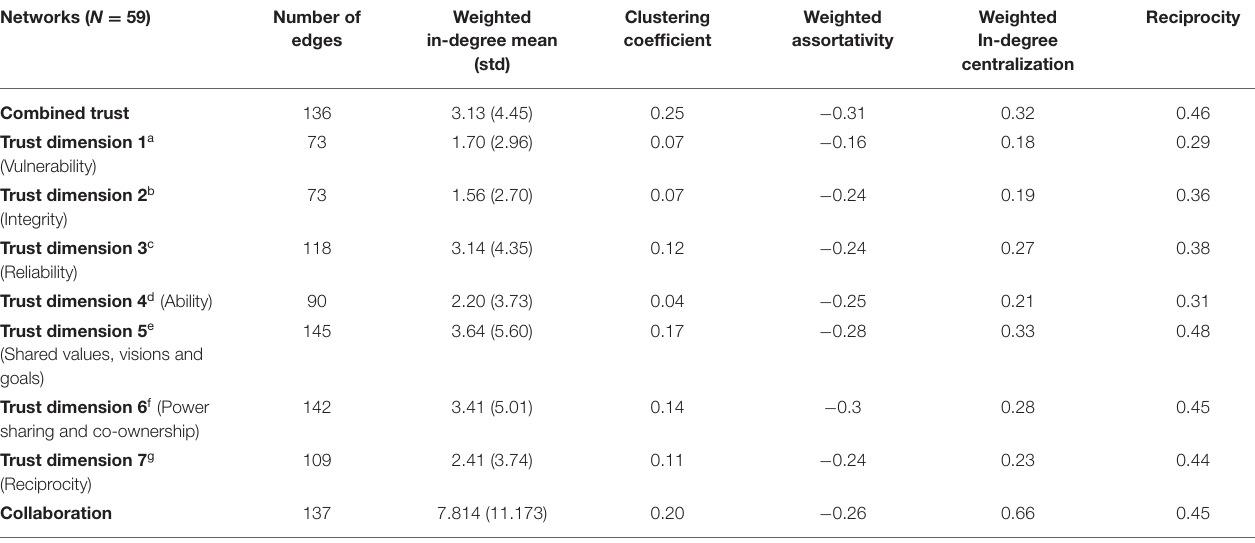
Clustering coefficient